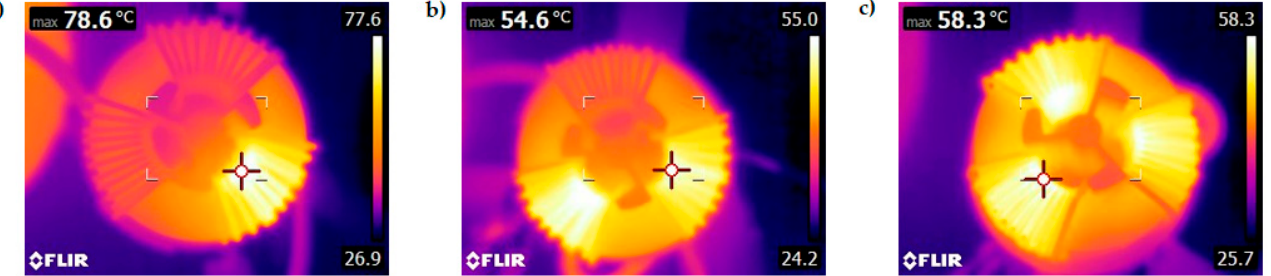
Figure 9. Dependence of inductance L 1 , L 12 , and L 123 on the direct current I DC at f = 200 kHz.